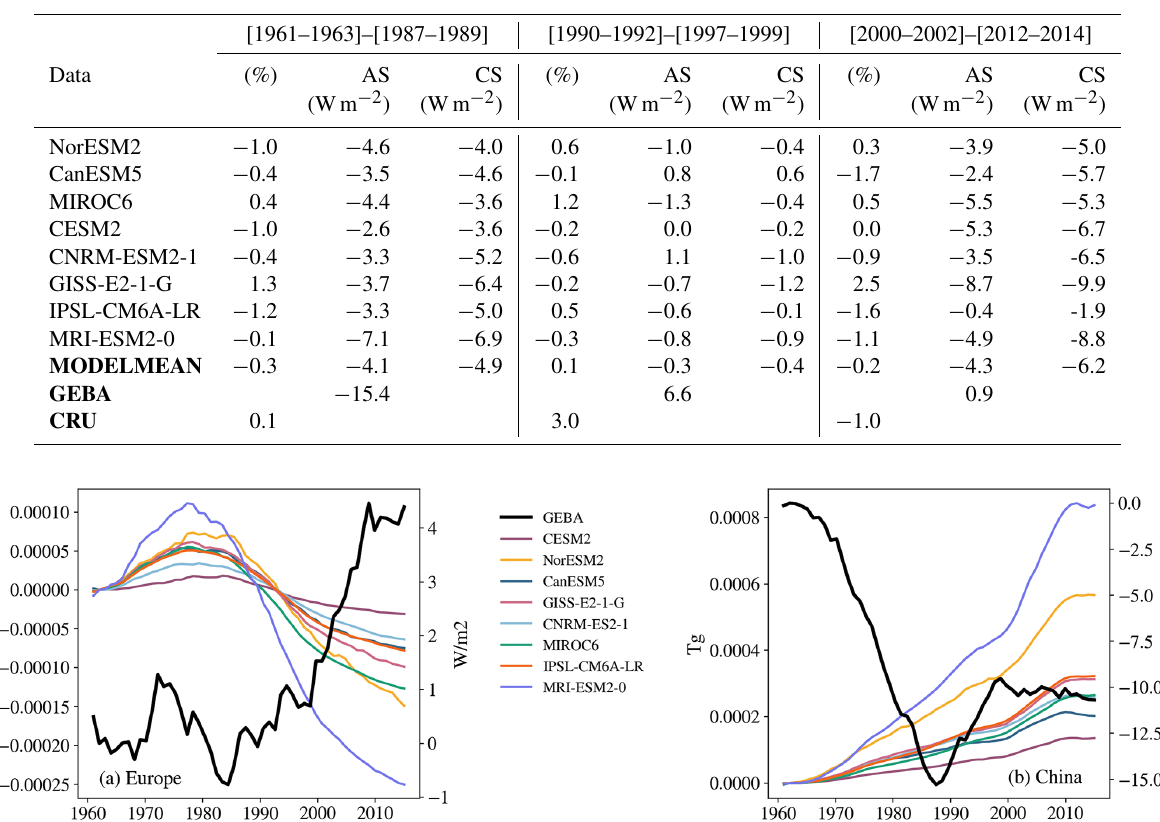
Figure 4. Anomaly of simulated atmospheric load of sulfate per model together with observed all-sky SDSR anomaly in (a) Europe and (b) China. The GEBA data are shown as yearly anomalies, while the atmospheric loads have been smoothed using a 10-year running mean technique as explained in Sect.